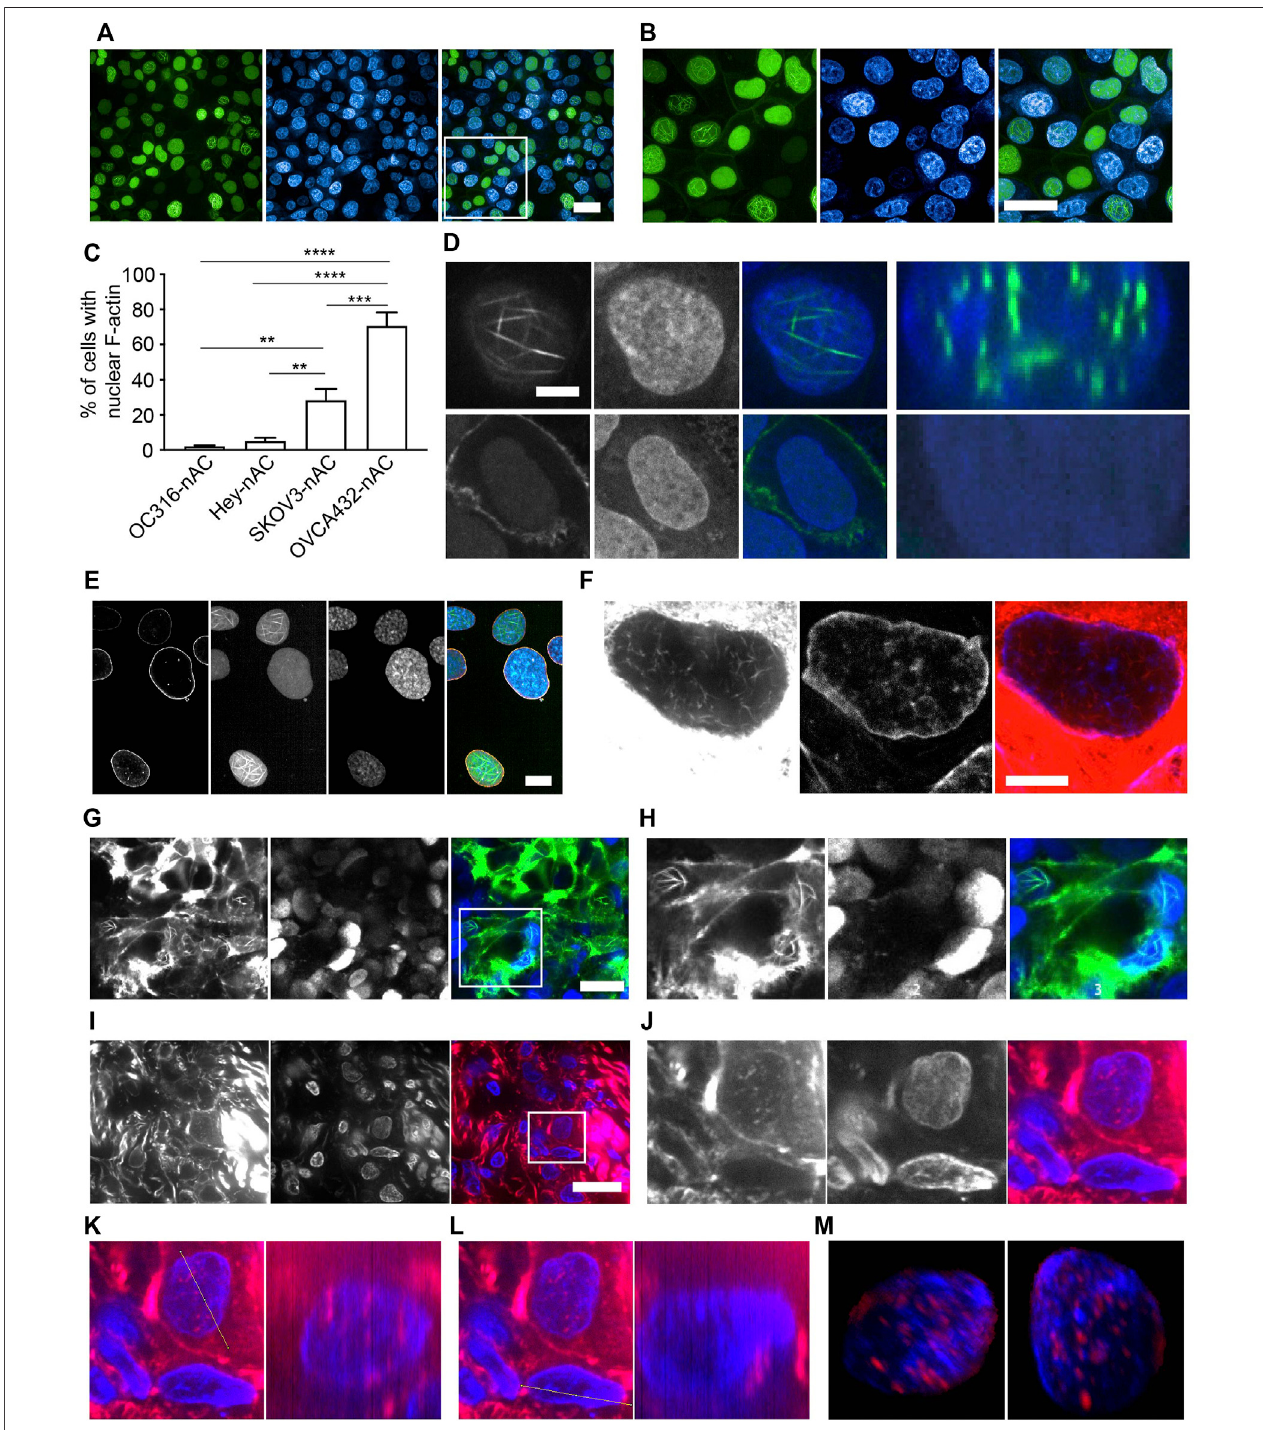
FIGURE 1 | Characterization ofnuclearF-actin structure in ovarian cancer cells. (A-B) , OVCA432-nAc-citrinecells with nuclear F-actinstructures.DAPI,blue.Green,nAc- citrine. Amagni fi ed imageof thewhiterectangleis pictured in (B) . Scale bar, 20 µm. (C) , Proportionofcells with thepresenceofnuclear F-actininovarian cancer celllinesstably expressingnAc-citrine.ThestatisticalanalysiswasperformedusingGraphpadPrism9.Thedatawasshownasmean±s.e.** p < 0.01and*** p < 0.001. (D) ,NuclearF-actinsignal (green) within the nucleus of a representative cell of the OVCA432-nAc-citrine cell line obtained using confocal Z-stack scanning and ImageJ Reslice analysis. The bottom showsacellwithoutnuclearF-actin.Green,nAc-citrine.Blue,DAPI.Scalebar,5 µm. (E) ,OVCA432-nAc-citrinecellsstainedforlaminA/C(orange).Green,nAc-citrine.Blue,DAPI. Scale bar, 5 µm. (F) , Nuclear F-actin in SKOV3 cells stained using rhodamine-phalloidin. SKOV3 cells were of no nAc-citrine expression. Scale bar, 10 µm. (G-H) , Spheroids of